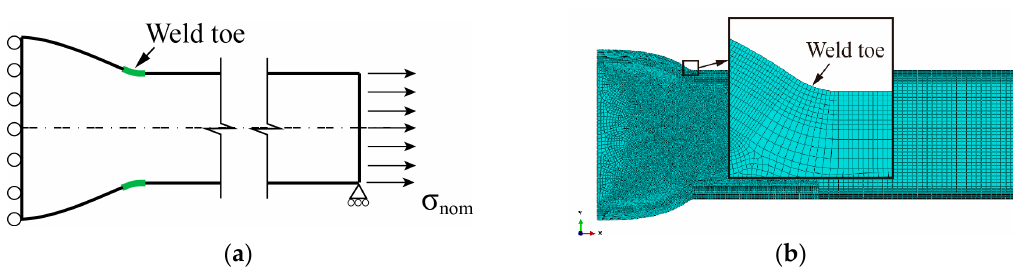
Figure 3. Finite element (FE) model for an undistorted butt-welded joint: ( a ) sketch of one-half model; ( b ) typical global and local meshes.